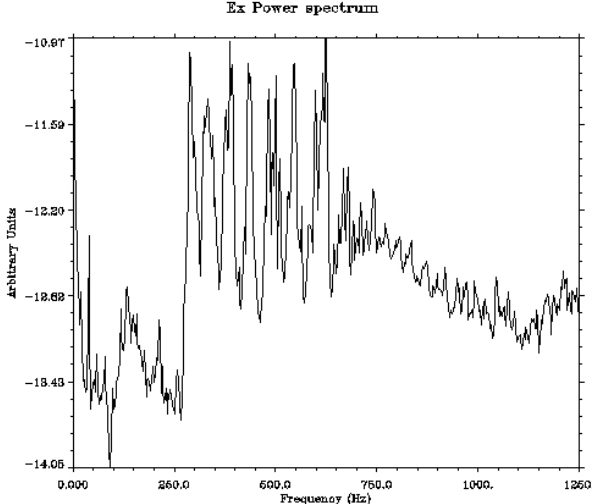
Fig. 2. Spectrum of the electric component E x . The analysis is performed between 09:14:30 and 09:16:30 UT using a 1024 point-FFT ( 1 f=2.44Hz).